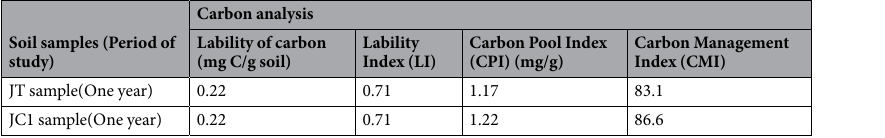
Table 3. Result of carbon turnover analysis. JT-Jeevaka Test, JC1-Jeevaka